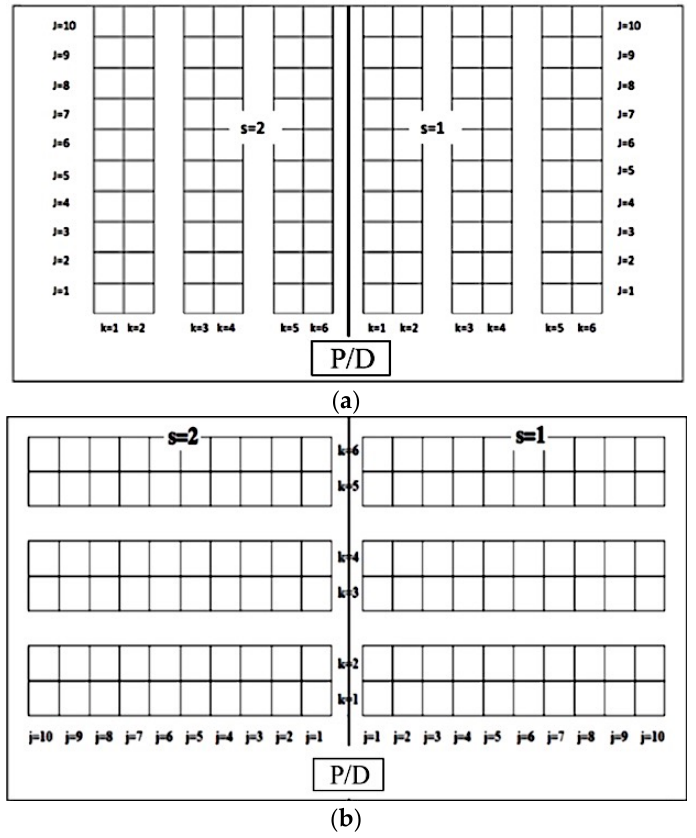
Figure 3. Nomenclature for longitudinal ( a ) and transversal ( b ) layout.